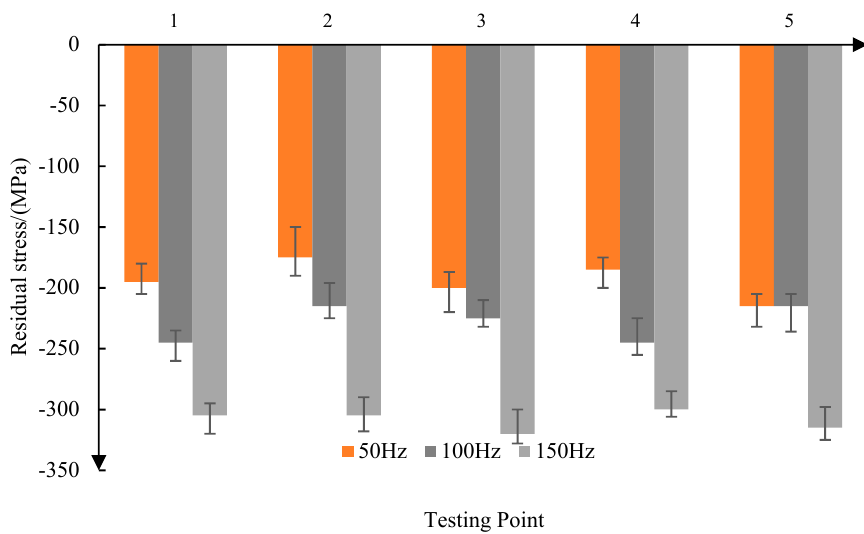
Figure 6. Effect of reciprocating frequency on residual stress.